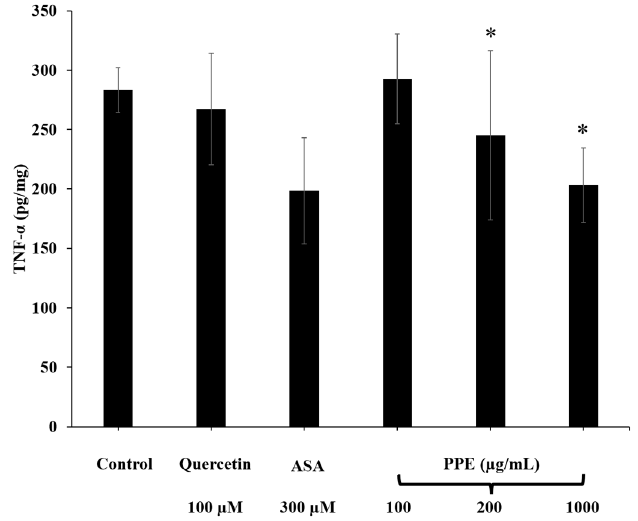
Figure 8. Inhibitory activity of 100 µM quercetin, 300 µM ASA, and various concentrations of PPE (100–1000 µg/mL) on TNF- α production in HaCaT cells. Data are expressed as mean ± SD ( n = 3). * indicates a significant difference compared to control ( p < 0.05).